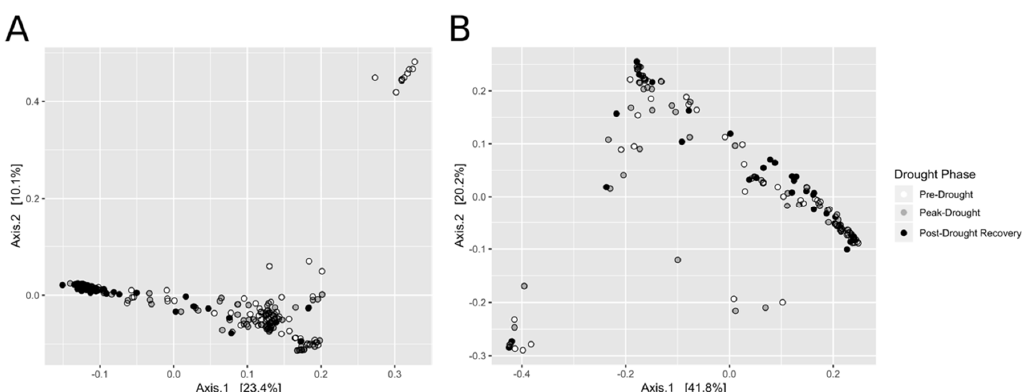
Figure 1. PCoA of Weighted UniFrac Distances by Drought Condition Stages. Principal coordinates plots of weighted UniFrac distance matrices illustrate patterns between sample groups. Ordinations are colored by drought condition phases and represent microbiome fingerprints of ( A ) bacterial 16S rRNA gene sequences and ( B ) fungal ITS sequences. The ordinations show, in a color gradient from white, to gray, to black, experiment phases (pre-drought, peak drought, and post-drought recovery, respectively). A convergence in the microbial communities are evident in the post-drought recovery stage for both bacteria and fungi.